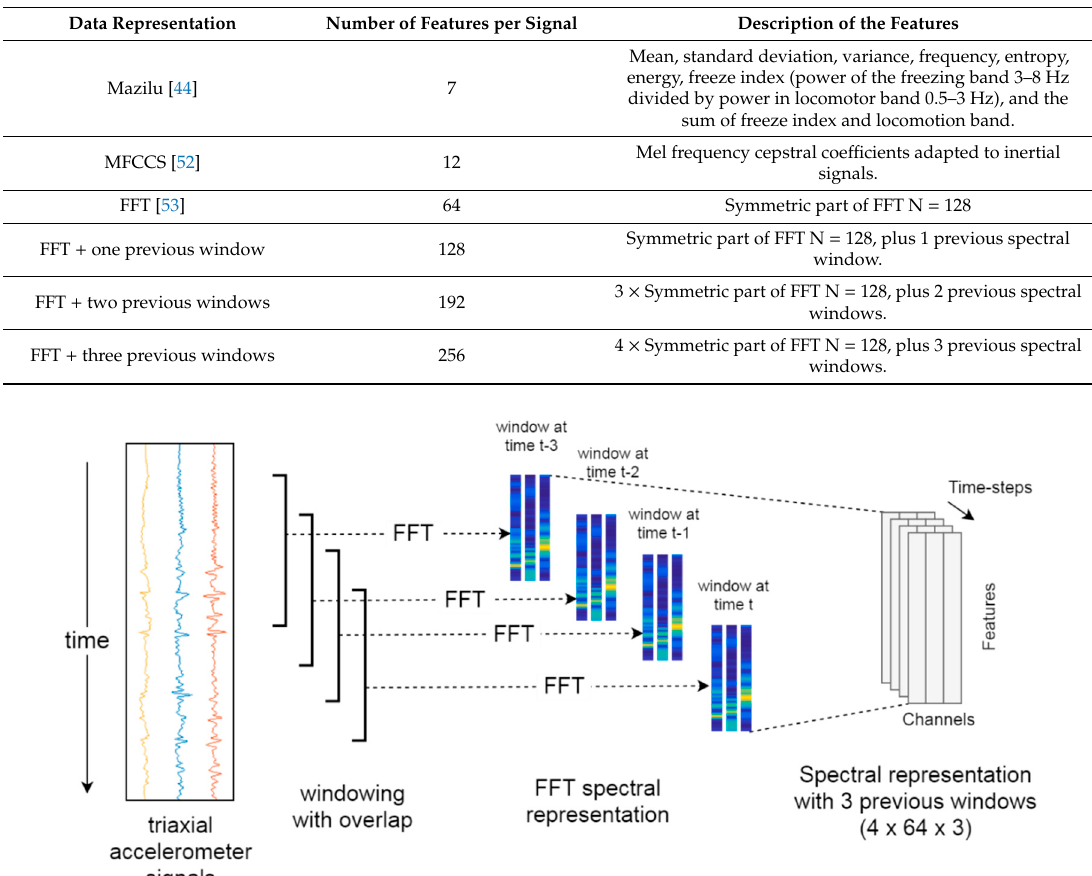
Table 2. Summary of the data representations used in the current study.